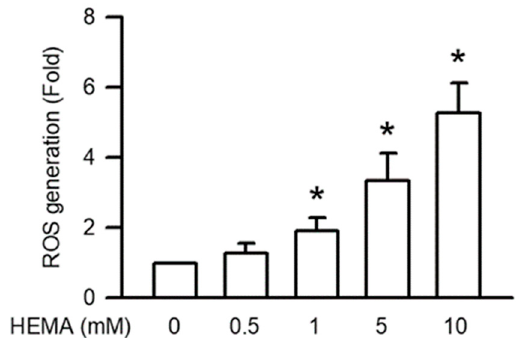
Figure 6. Generation of ROS was induced by HEMA in RAW264.7 cells. After 24 h of treatment with HEMA, DCFH-DA measured ROS generation. Data are expressed as mean ± SD. The number of parallel measurements is 4. * means that p < 0.05 compared with HEMA at the concentration of 0 mM.